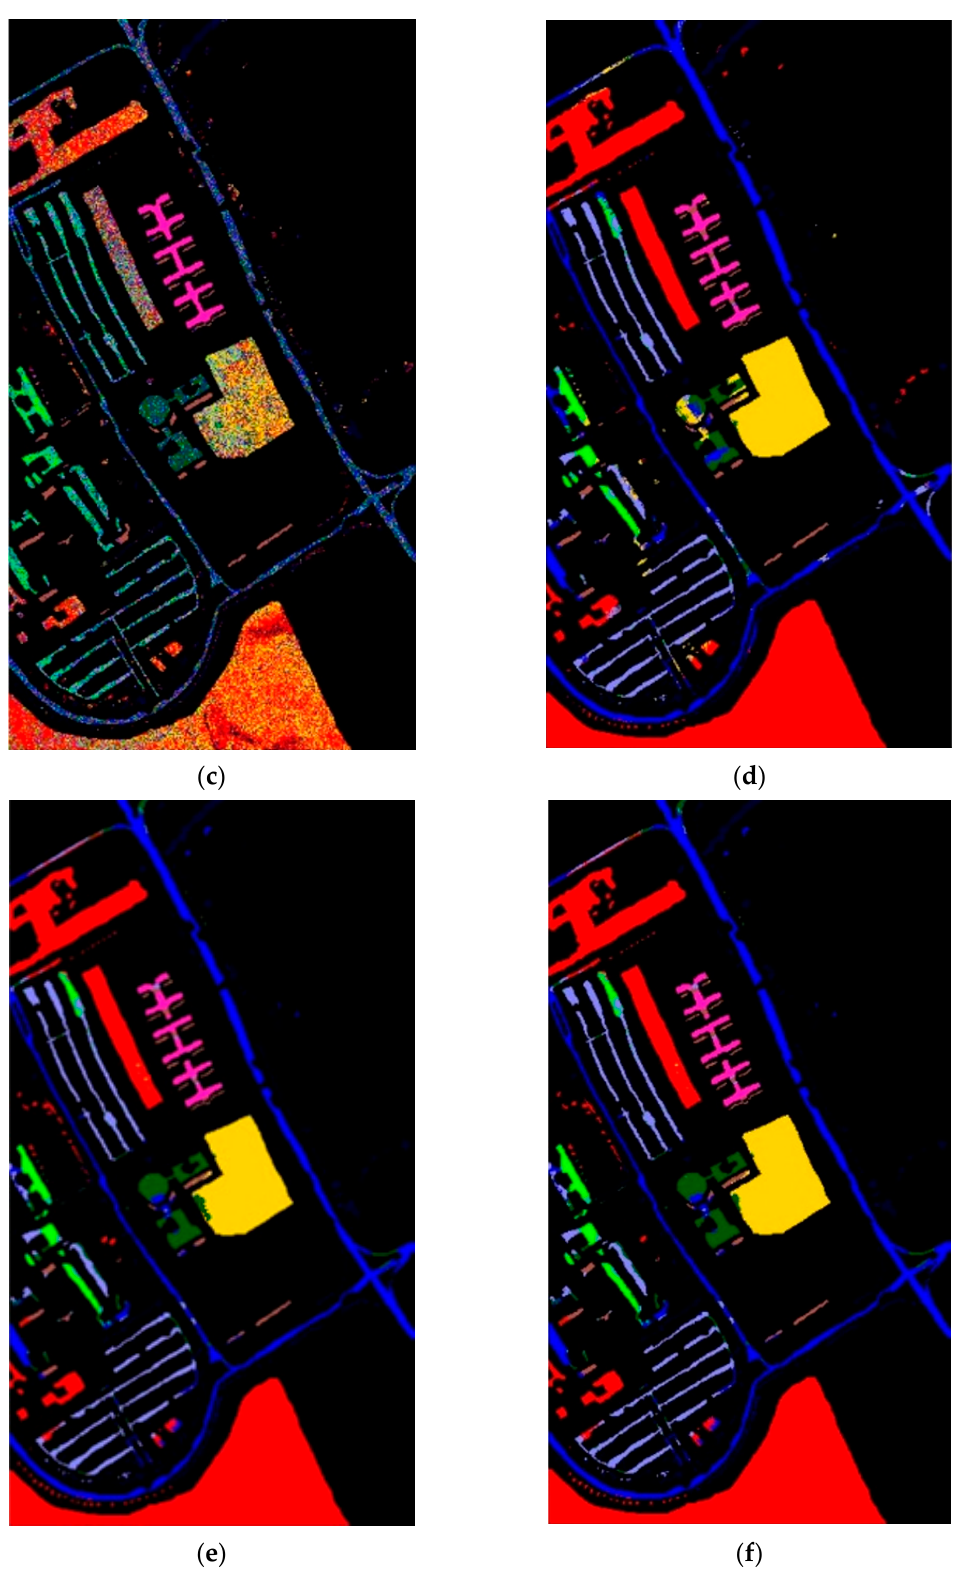
Figure 8. The classification label maps of dataset Pavia University. ( a ) (PCA, NN) ( b ) (PCA + FLE, NN), ( c ) (PCA + SVMFLE, NN), ( d ) (PCA, GAN), ( e ) (PCA + FLE, GAN), and ( f ) (PCA + SVMFLE, GAN).